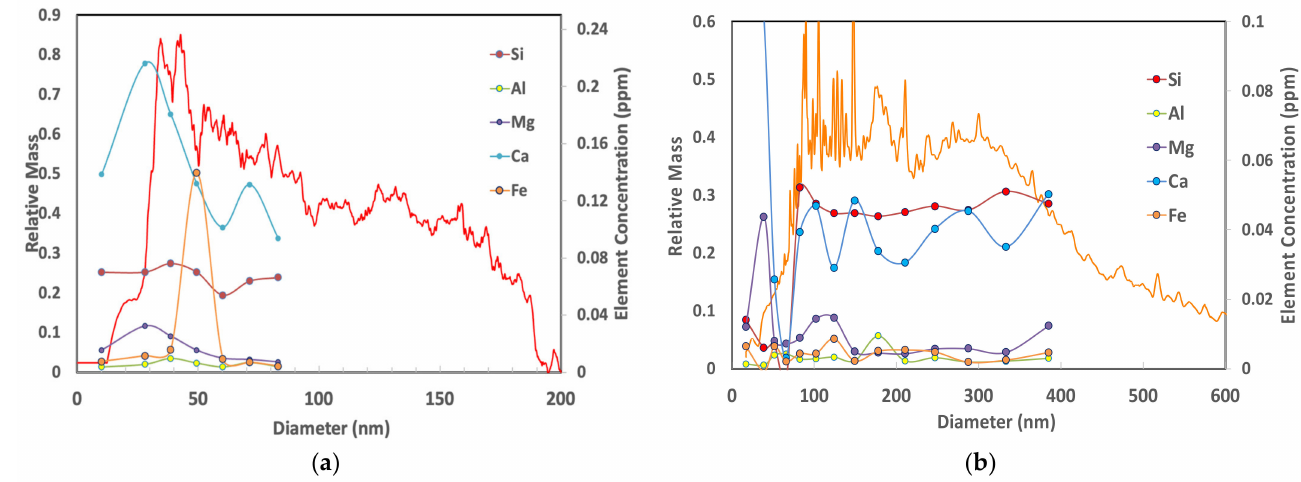
Figure 7. Size-dependent elemental distribution of major elements, Si, Al, Ca, Fe and Mg in nanoparticles isolated from the miner sample. The red ( a ) and orange ( b ) lines show the size distribution, measured by asymmetrical flow field-flow fractionation ( a ) and sedimentation field-flow fractionation ( b